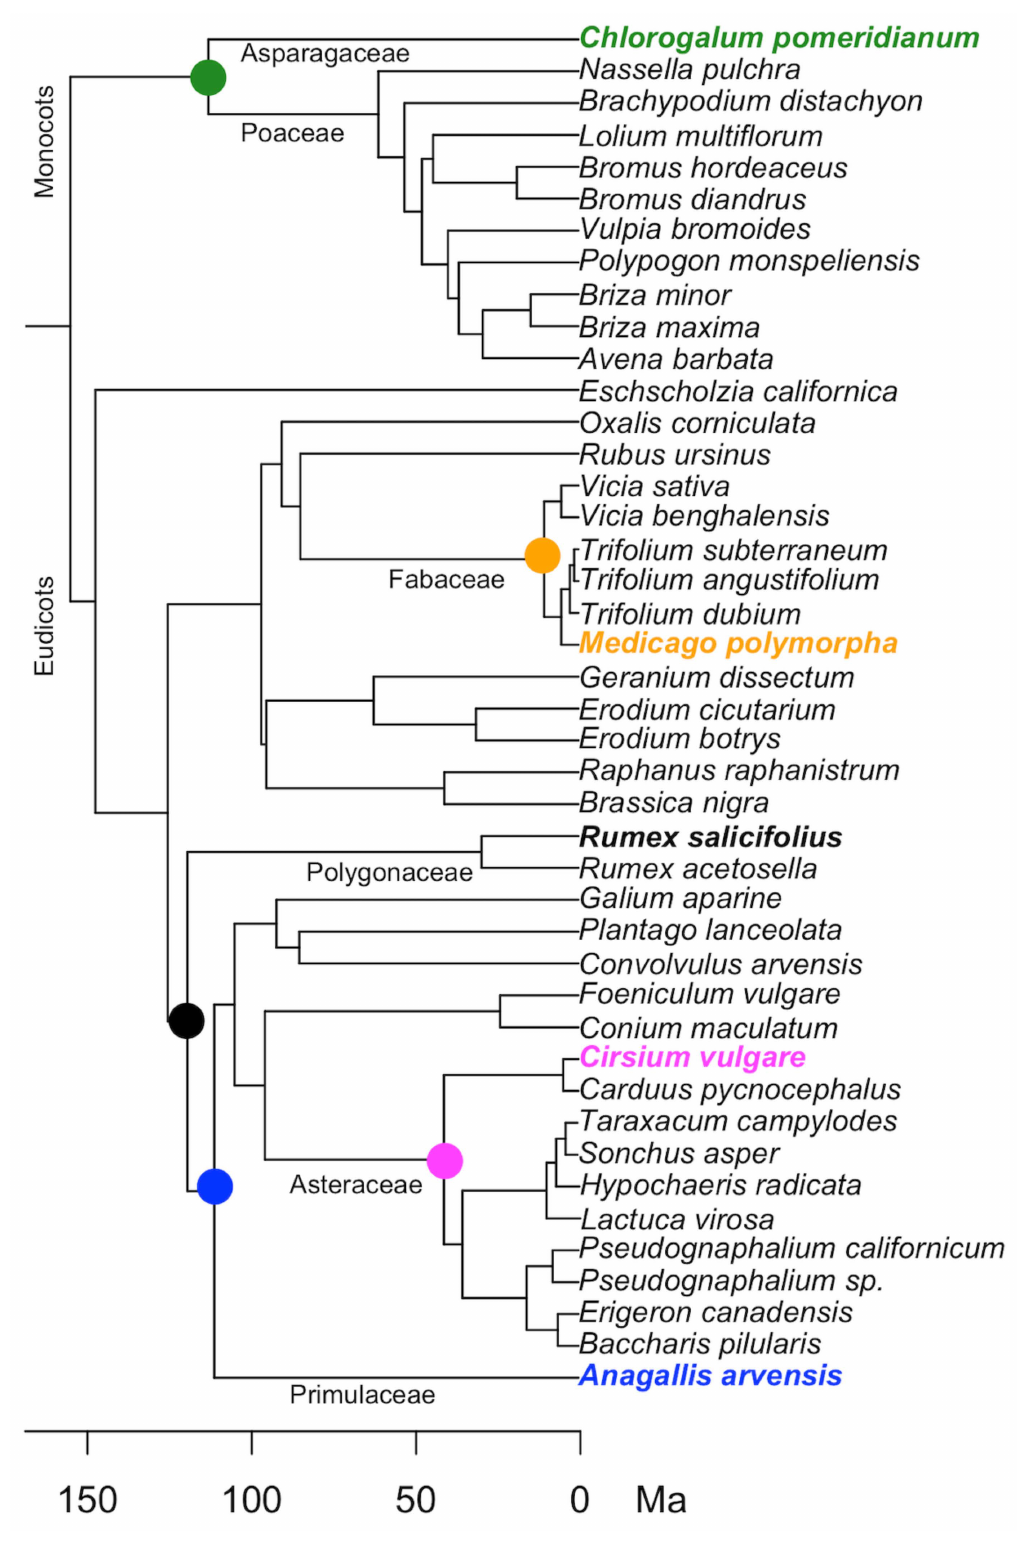
Figure 1. Phylogenetic tree of the 43 angiosperm plant species recorded in ten 20 m radius plots in a meadow on the UC Santa Cruz campus in coastal California. Units (Ma) are millions of years ago. See details of plant sampling and tree construction in Parker et al. [25]. Colored circles indicate the node distance that corresponds to the PD10 phylogenetic distances discussed in Section 3.2. The dated Newick file for the tree and code to visualize and analyze the tree are given in File